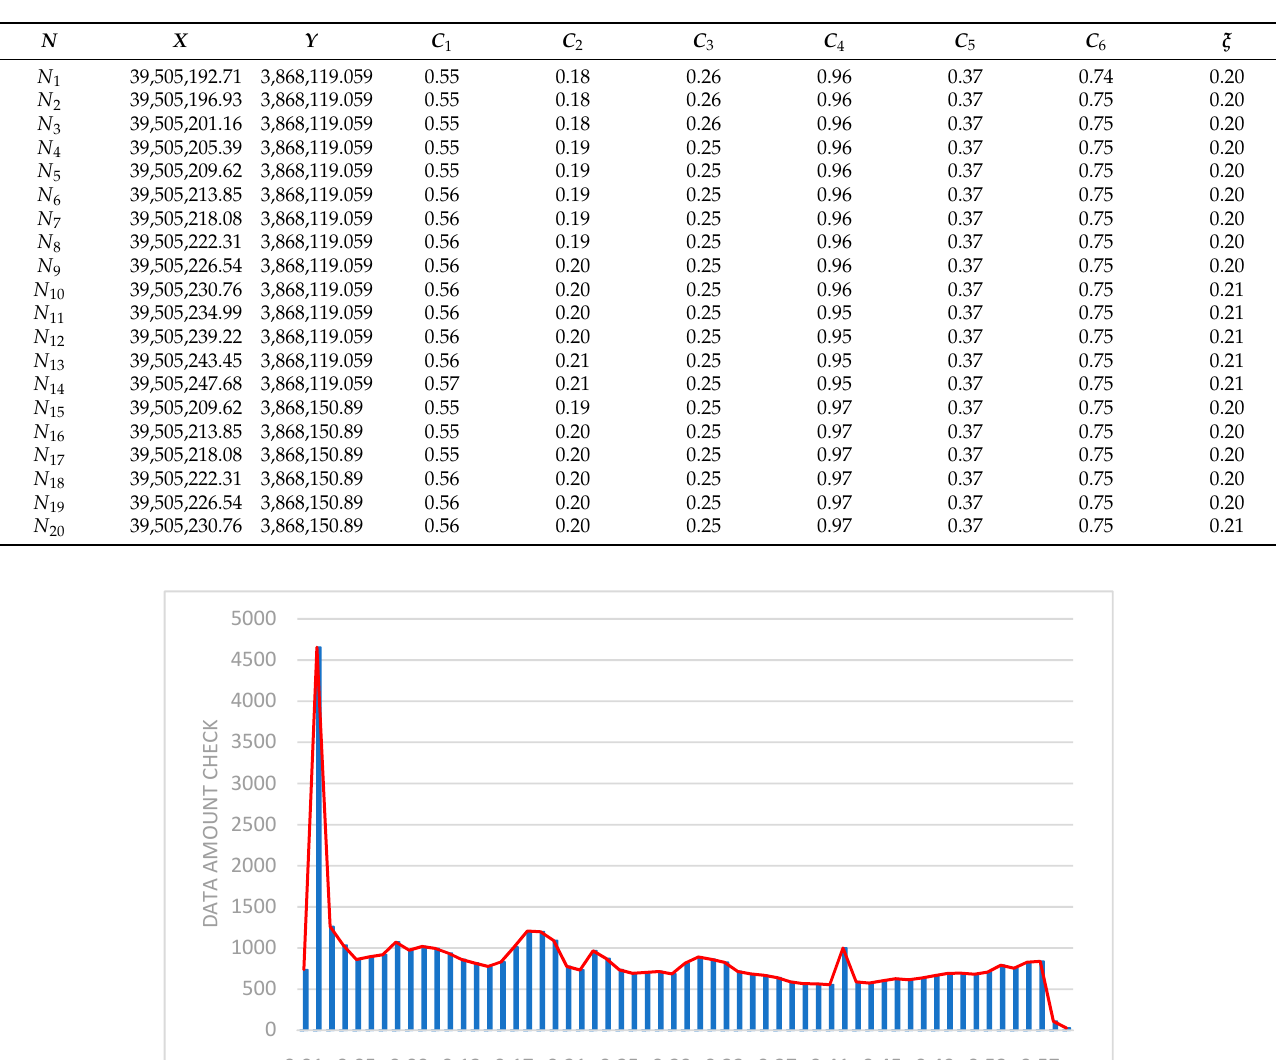
Table 5. Partial water inrush index data (standardization).